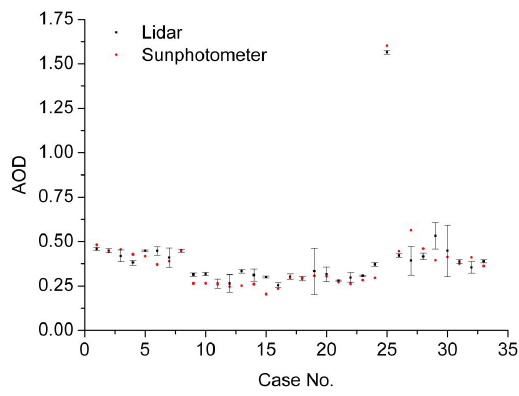
Fig. 8. A comparison of AOD derived by lidar and sunphotometer (Case No. is same as that in Table 3) shows a good consistency between two retrievals.